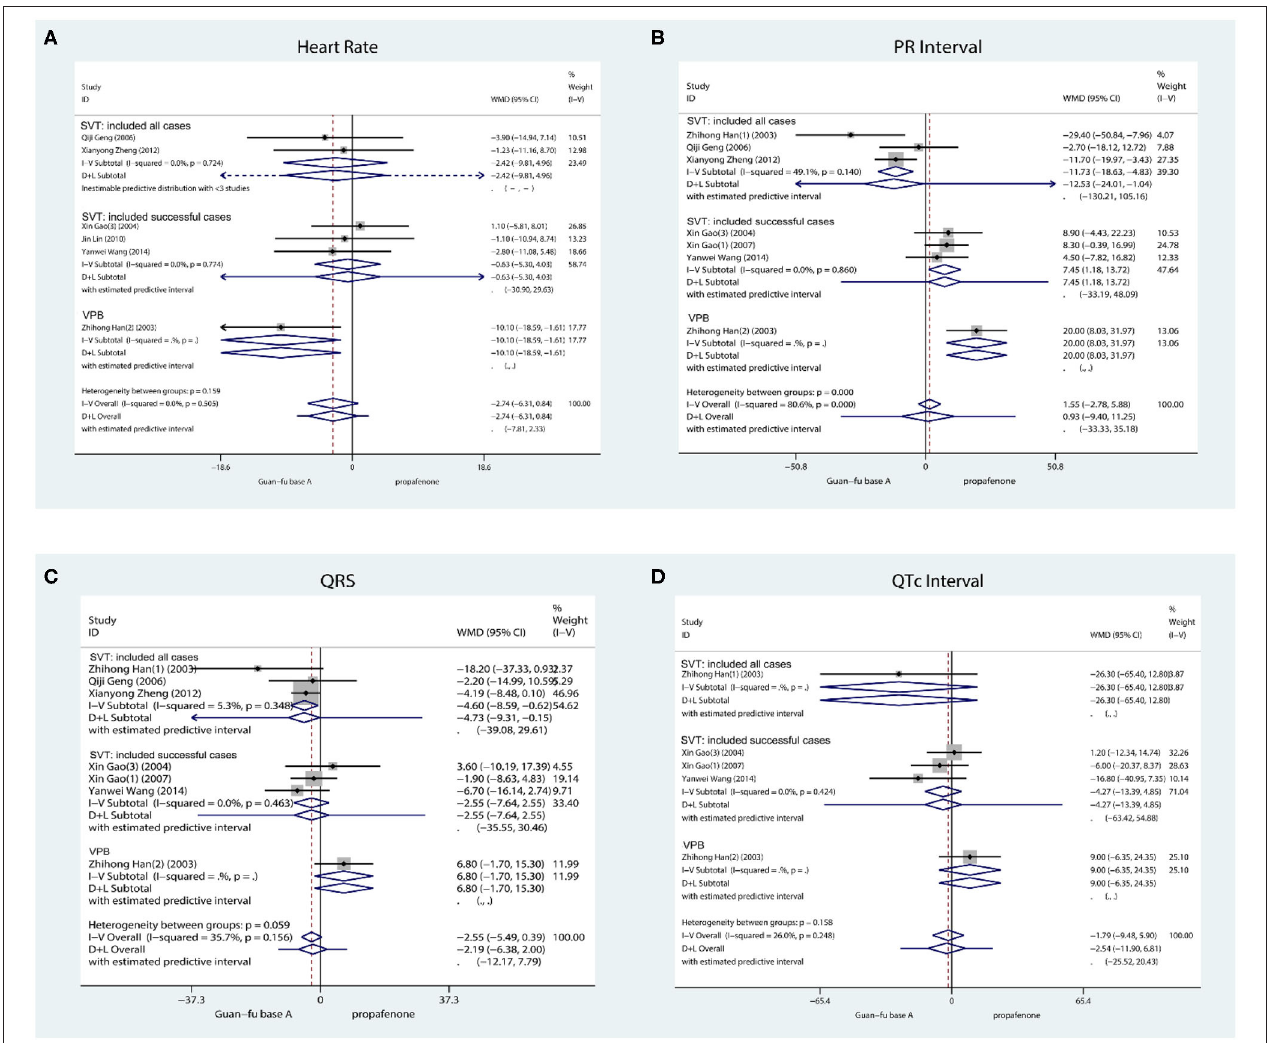
FIGURE 4 | Forest plot comparing the GFA with Propafenone in ECG indicator. (A) Forest plot comparing the GFA with Propafenone in HR. (B) Forest plot comparing the GFA with Propafenone in PR. (C) Forest plot comparing the GFA with Propafenone in QRS complex. (D) Forest plot comparing the GFA with Propafenone in QTc